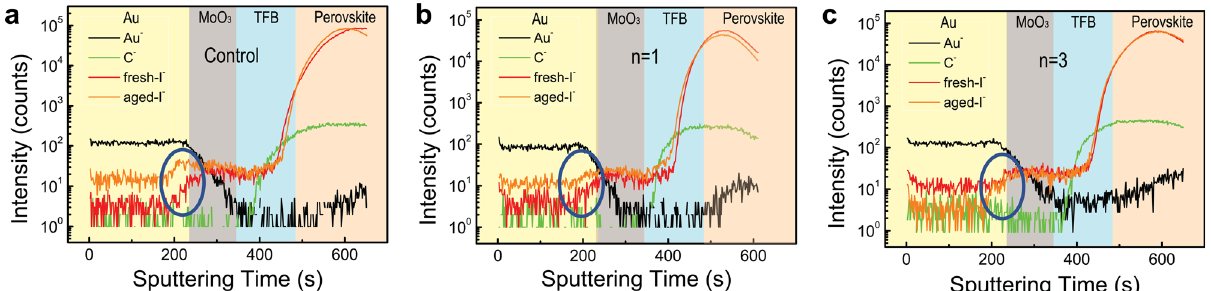
Fig. 3 ToF-SIMS measurement results. ToF-SIMS of fresh device and aged device for a control sample, b PMAI ( n = 1)-passivated device, c PPAI ( n = 3)- passivated device. The blue circle highlights the local accumulation of iodide (I − ) ions close to gold